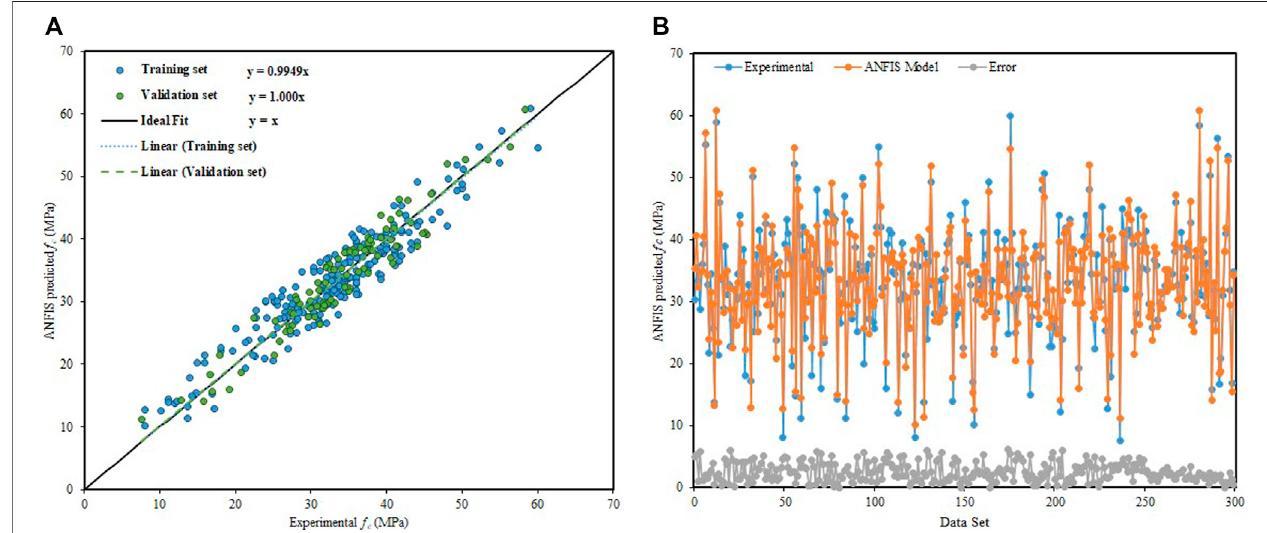
FIGURE 6 | ANFIS model predictive results. (A) Regression line slope of the ANFIS model. (B) Dispersion of absolute error values of the ANFIS model.